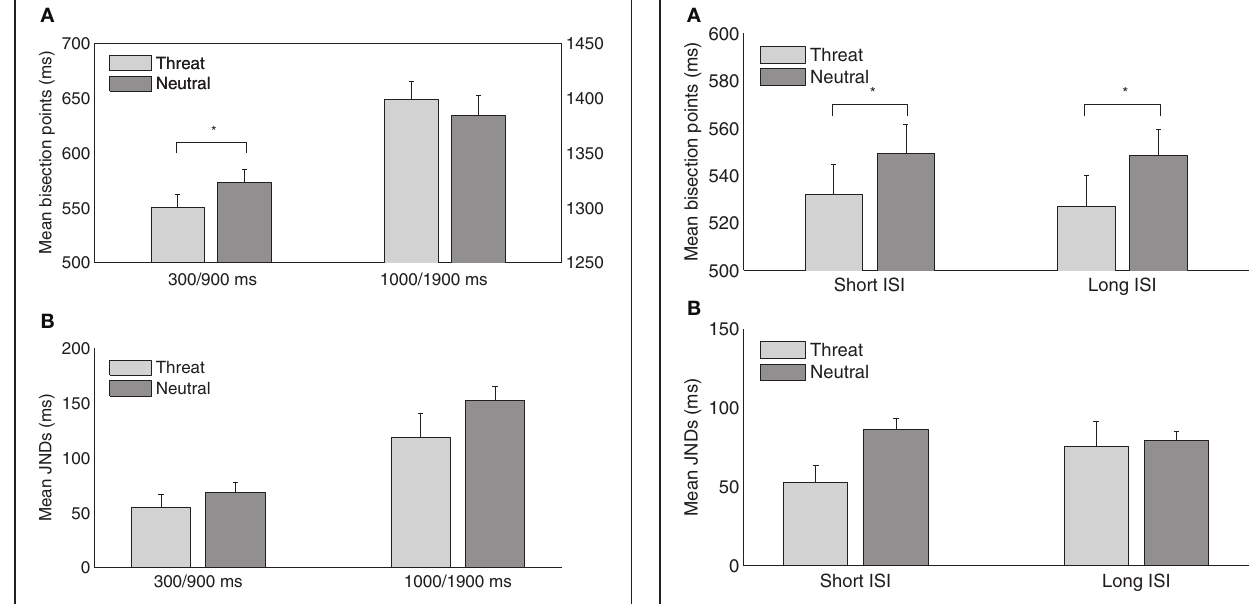
long- than the short-range task, [ F ( 1 , 14 ) = 32 . 61, p < 0 . 01], and